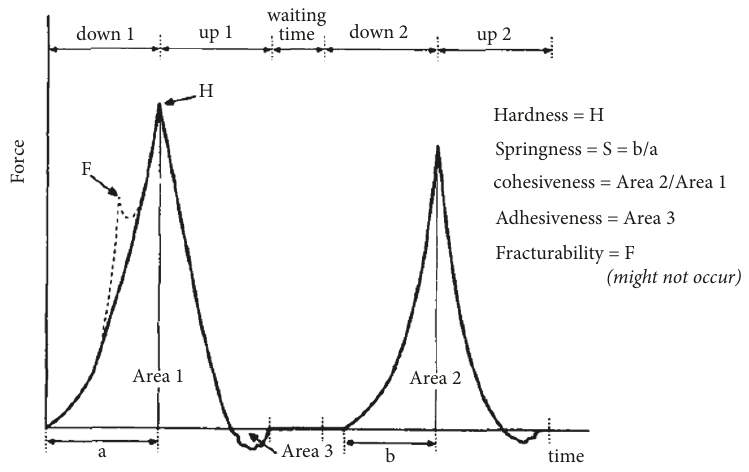
Figure 5: Instrumental texture profile analysis obtained with a TA-XT2 Texturometer